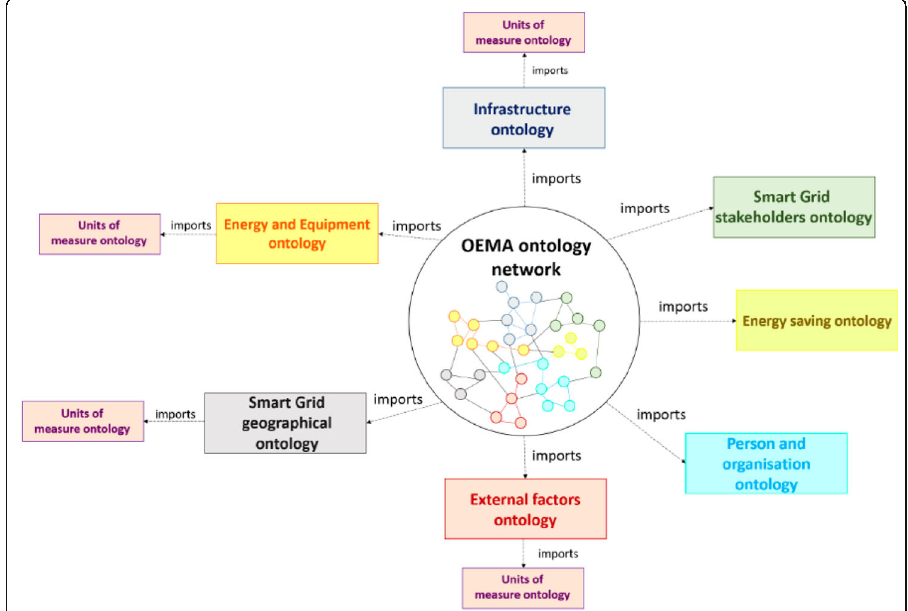
Fig. 3 OEMA (Ontology for Energy Management Applications) ontology network structure (Cuenca et al.